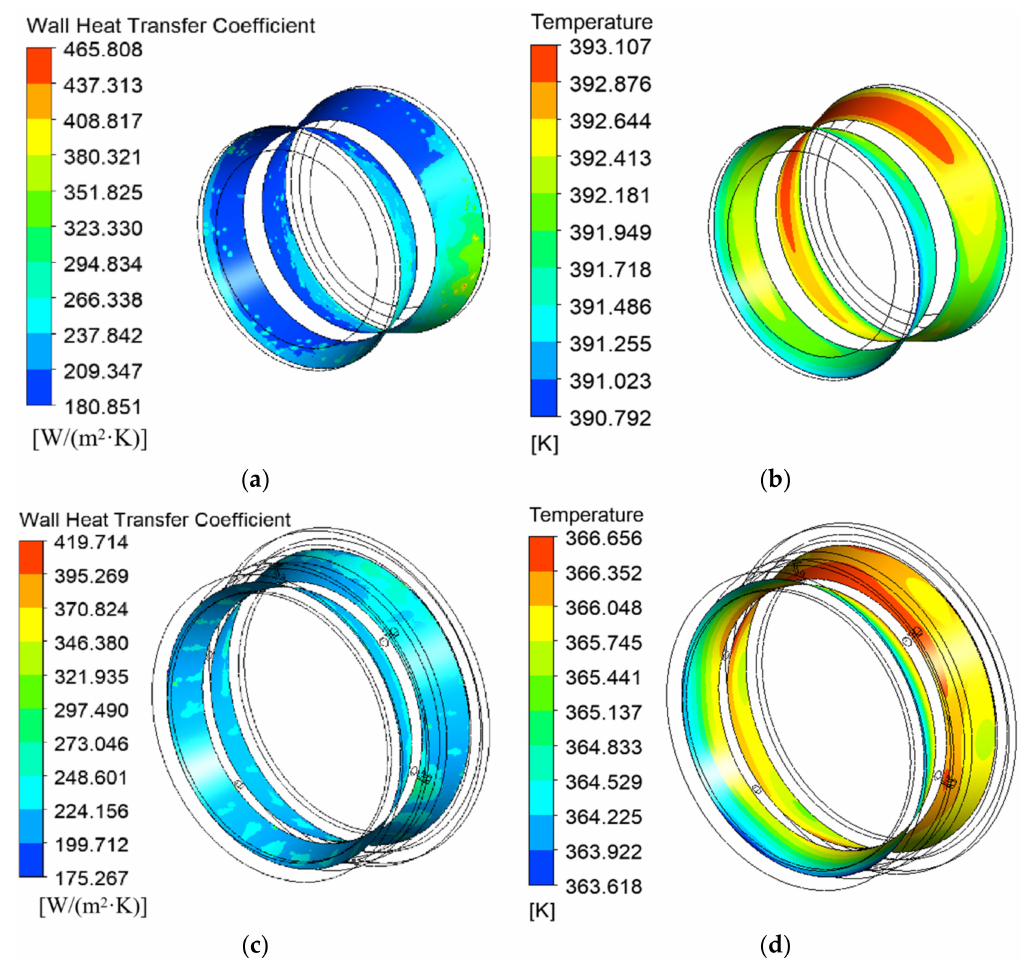
Figure 19. Temperature characteristics of raceways: ( a ) convective heat transfer coefficient of inner ring; ( b ) temperature of inner ring; ( c ) convective heat transfer coefficient of outer ring; ( d ) temperature of outer